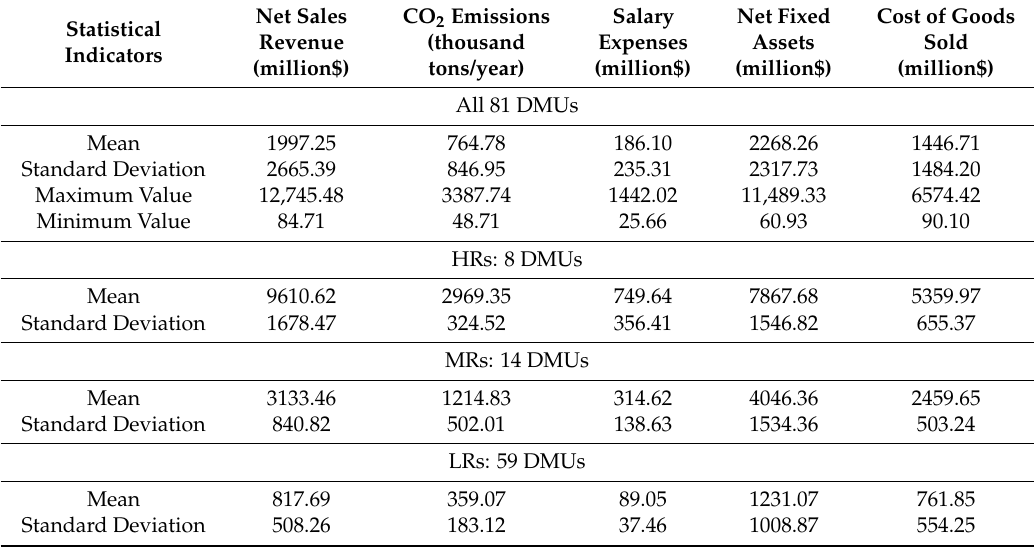
Table 1. Descriptive Statistics for Empirical Variables. DMUs: decision-making units, HR: high revenue, MR: middle revenue, LR: low